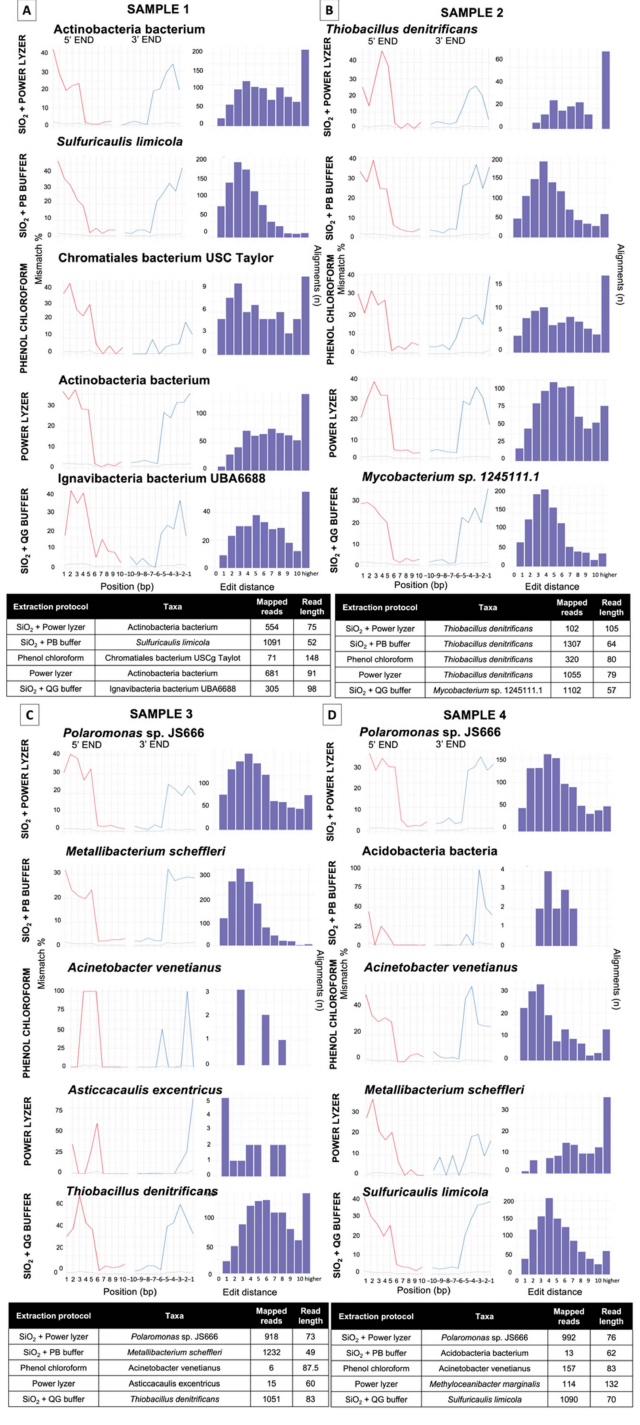
Figure 6. DNA damage profiles of the most abundant species per dataset. Cytosine deamination and edit distance plots of the most abundant species in ( A ) Sample 1, ( B ) Sample 2, ( C ) Sample 3 and ( D ) Sample 4, extracted using five DNA extraction methods and preprocessed with the selected bioinformatic pipeline (AdapterRemoval v2, 55kx, deduplication of exact sequences). Plot were obtained using HOPS with the ancient filter and the GTDB a reference database. The left and right panels of cytosine deamination plots for each sample display the 5 (cid:48) C-to-T (red lines) and 3 (cid:48) G-to-A (blue lines) substitution rates,